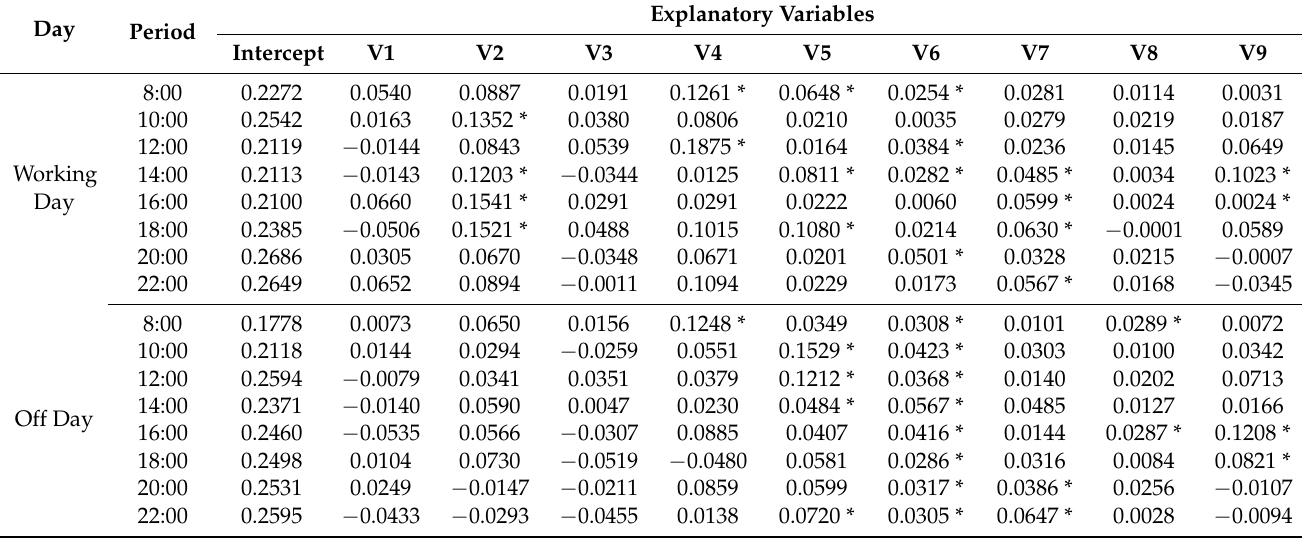
Table 9. The OLS regression results for the WYJ station